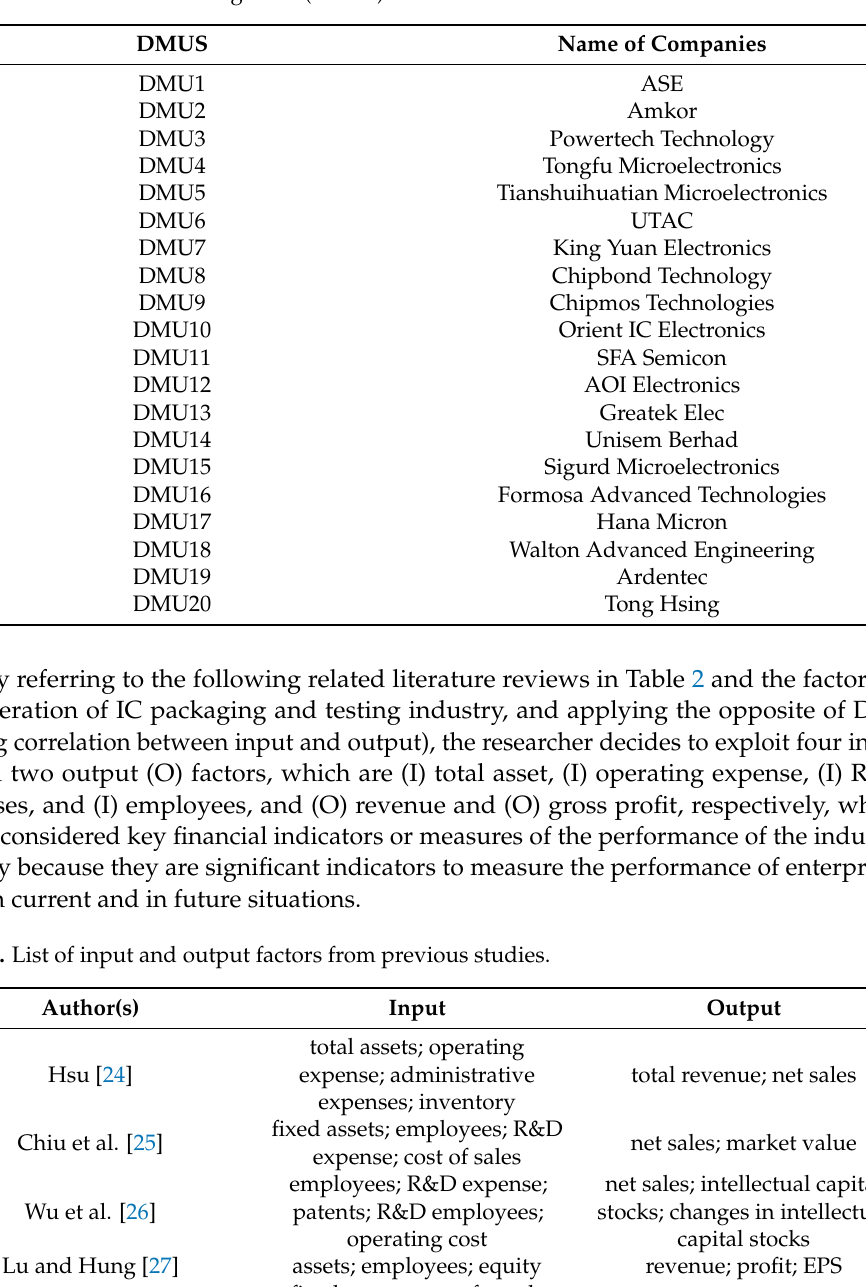
Table 1. List of decision making units (DMUs).